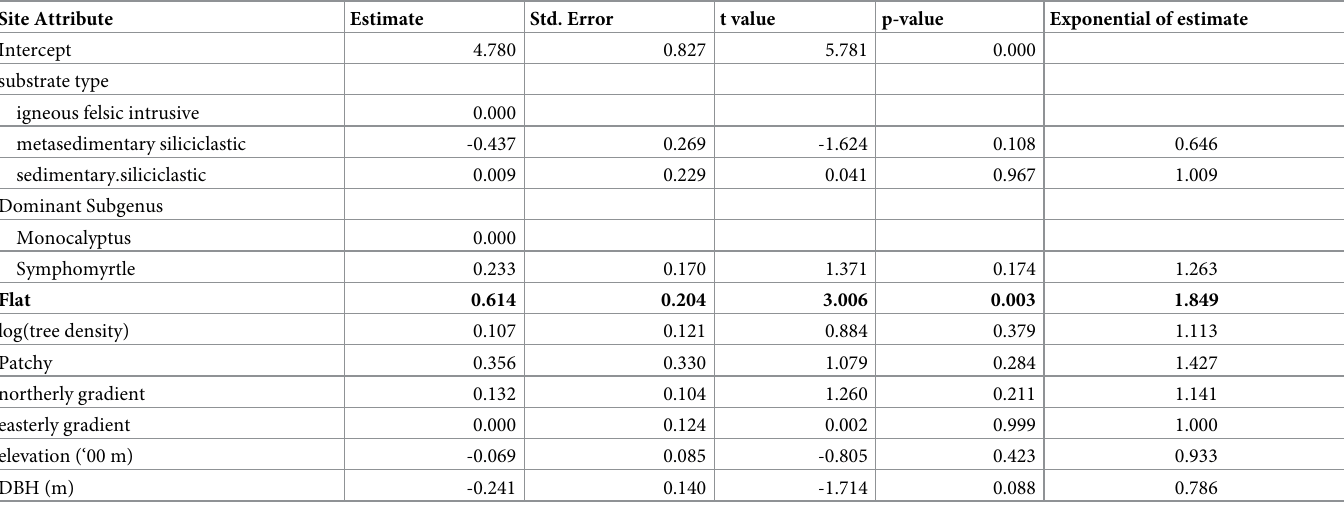
Table 3. Linear mixed model of the logarithm of bark sodium content for 285 E . mannifera